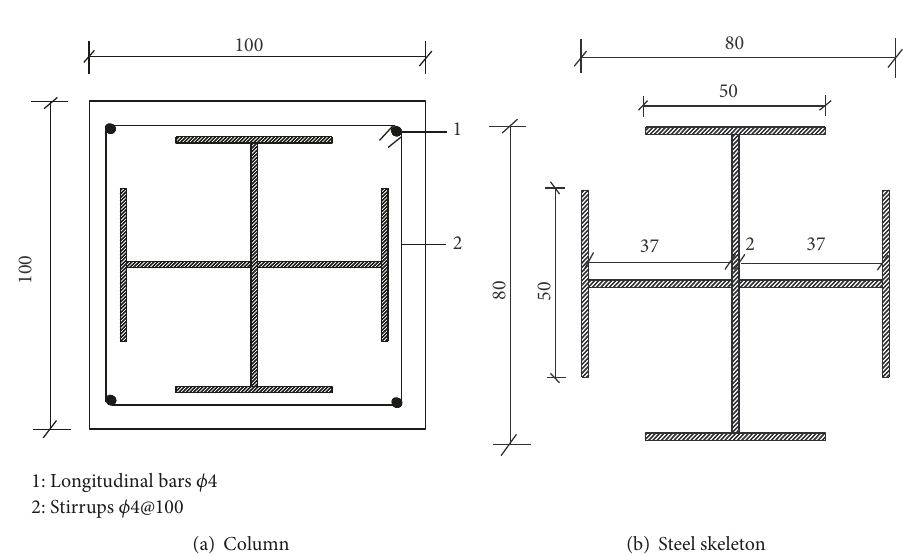
Figure 2: Configurations and skeleton of CS columns (units: